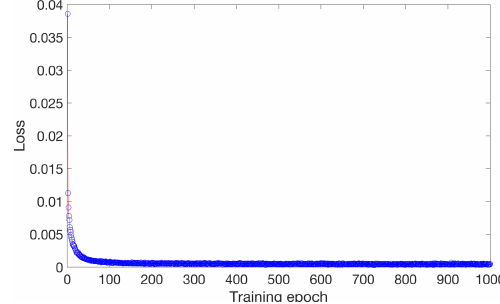
Figure 4. Training results of CNN classification model